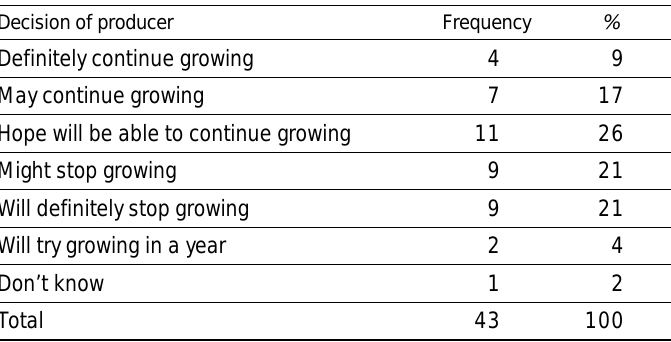
Table 7. Decision Taken by Producers for Growing Wheat if Subsidy Is